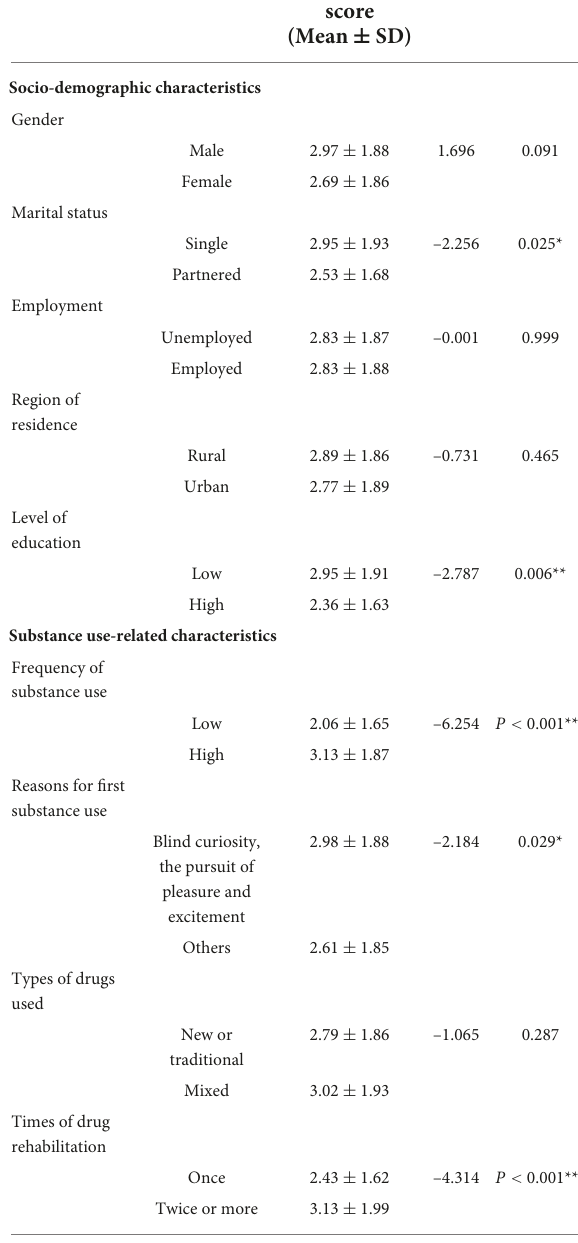
TABLE 2 Comparison of drug craving between categories of socio-demographic and substance use-related variables.